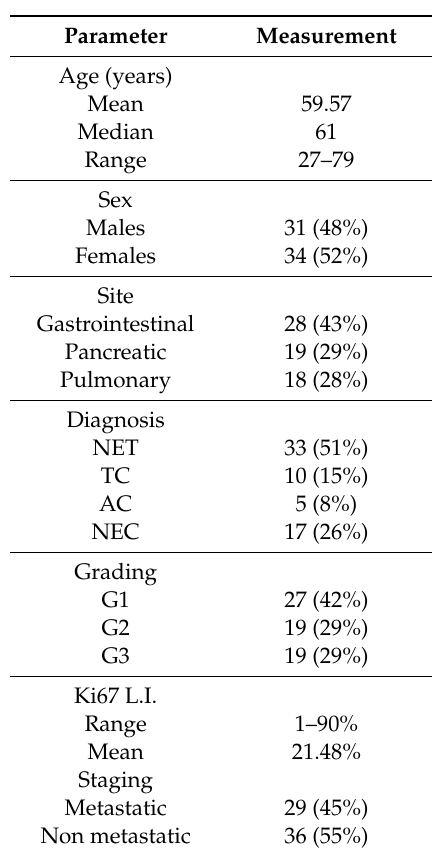
Table 3. Grouping of cases based on the clinico-pathological